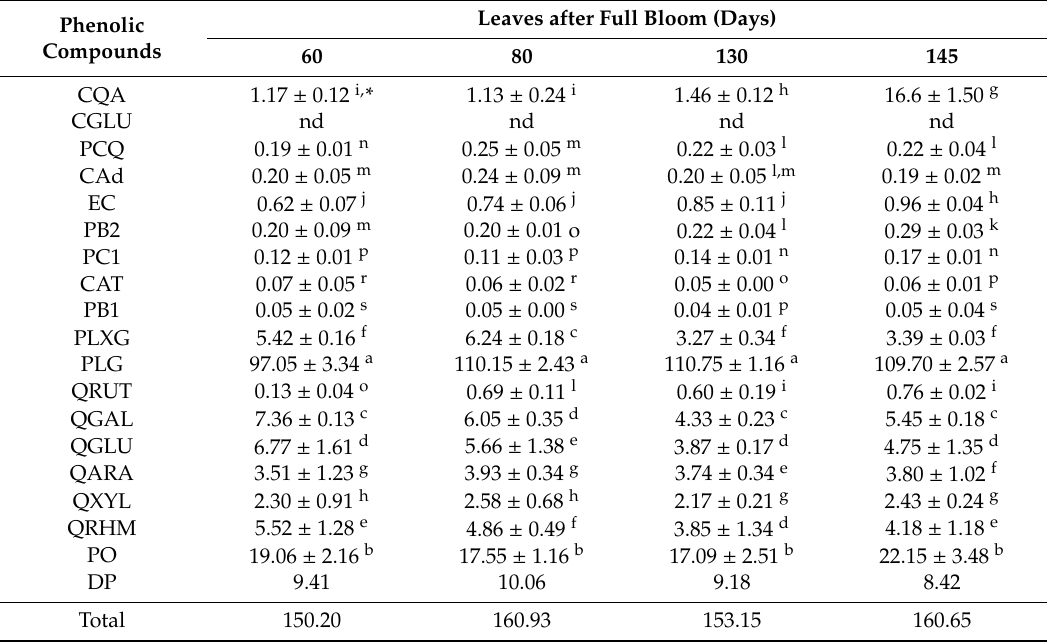
Table 3. Change in the polyphenol content (g kg − 1 dw) in the leaves of Ozark Gold cv. during the developing and ripening of the